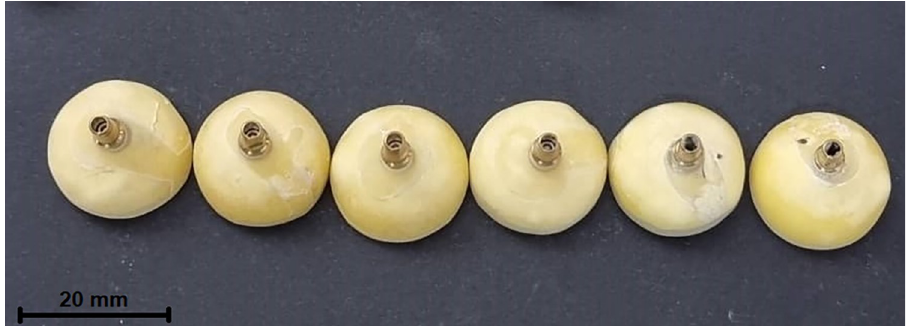
Fig 1. Titanium-based abutments and analogs embedded in acrylic material.